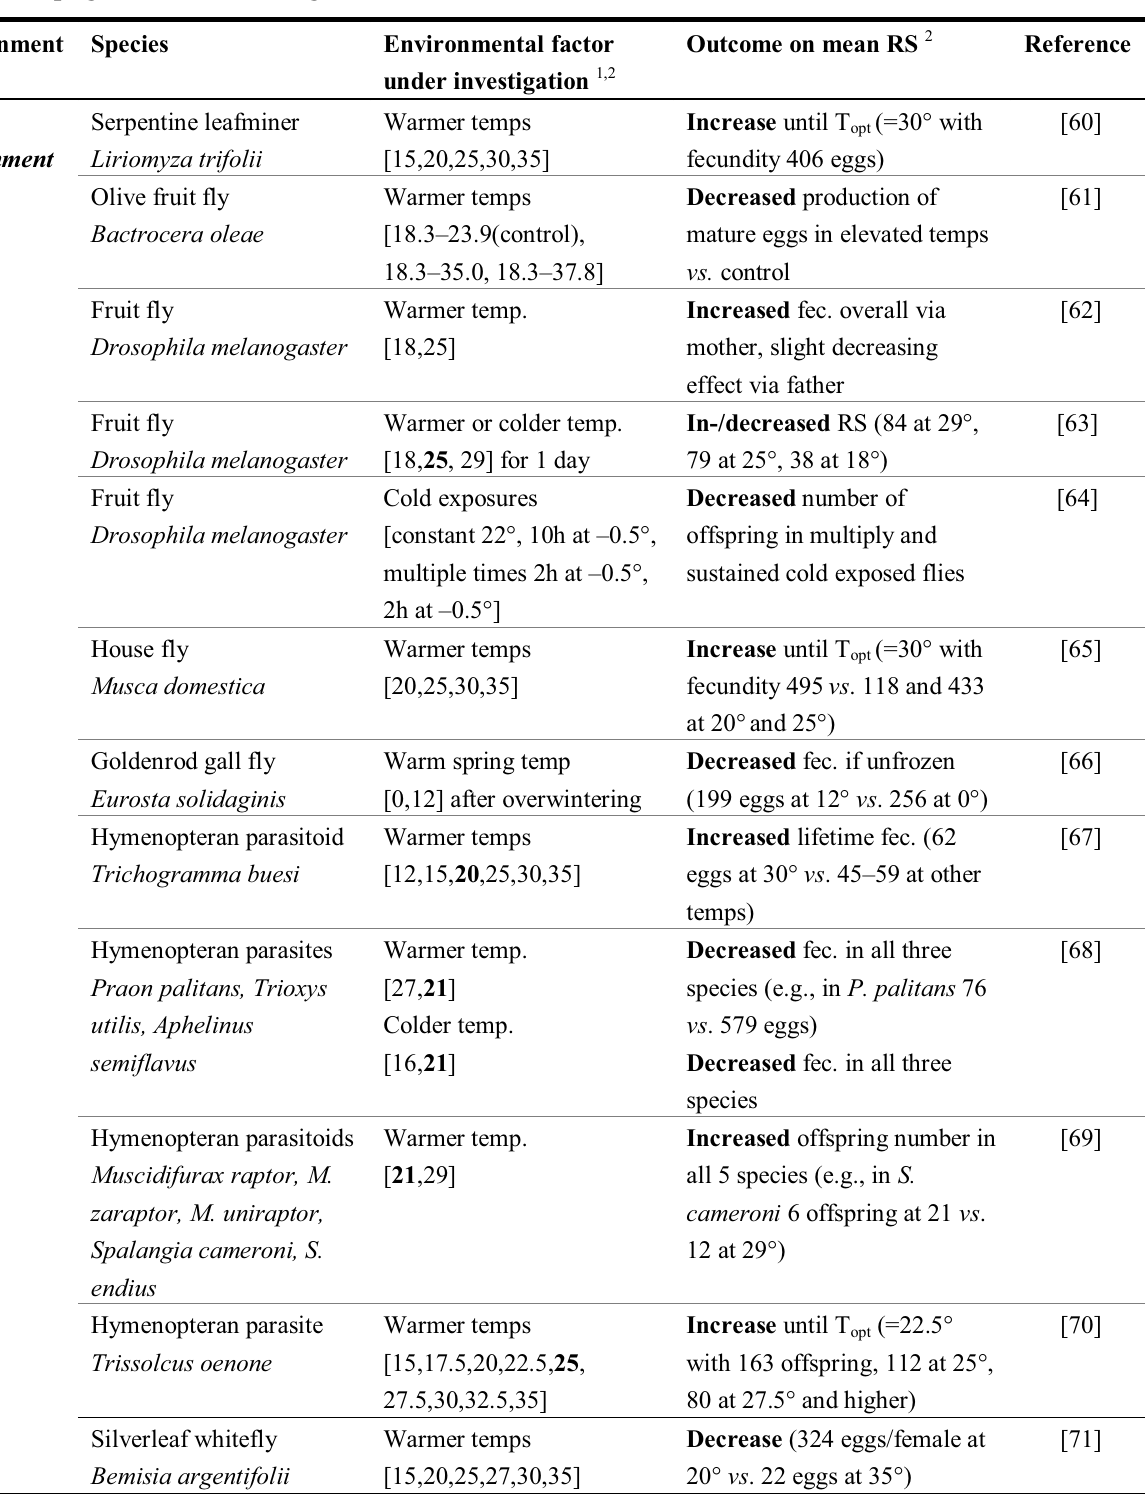
Table 2. Examples of studies assessing effects of climate change on reproductive success (RS) including fecundity, fertility or number of offspring. The studies are divided between lab-based experiments using different controlled temperature treatments, and experiments investigating RS in the field by observing or simulating changes to natural and anthropogenic climate